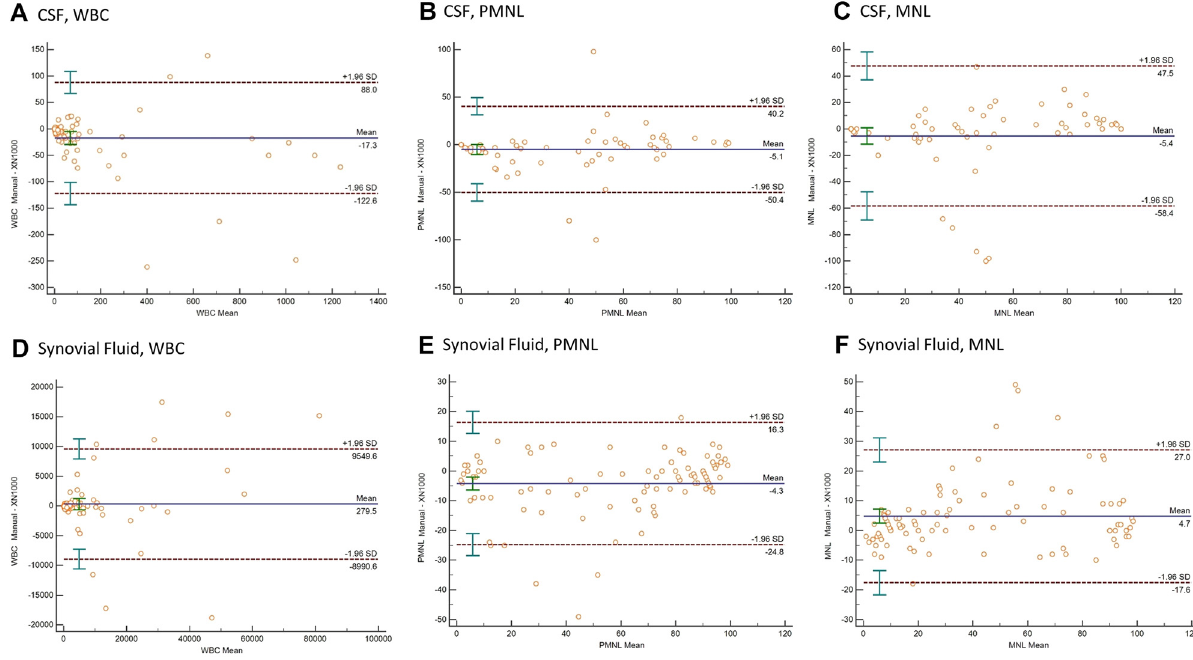
Figure 2: Bland-altman plots for the CSF and synovial fluids. CSF, cerebrospinal fluid; MNL, mononuclear leukocytes; PMNL, polymorphonuclear leukocytes; WBC, white blood cells. Mean absolute differences are blue, 95% limits of agreement are dashed red, confidence intervals are